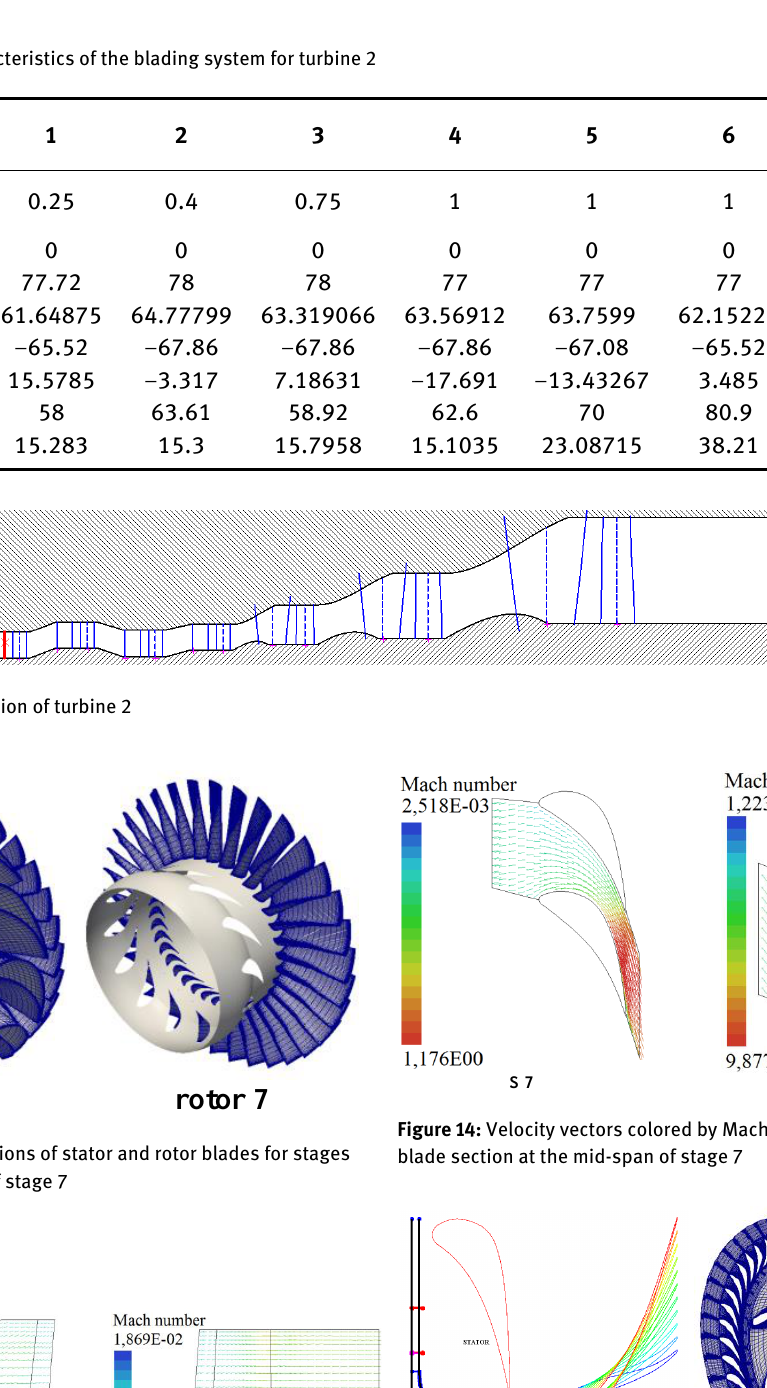
R Figure 16. Velocity vectors colored by Mach number in a meridional section at the mid blade-to-blade distance